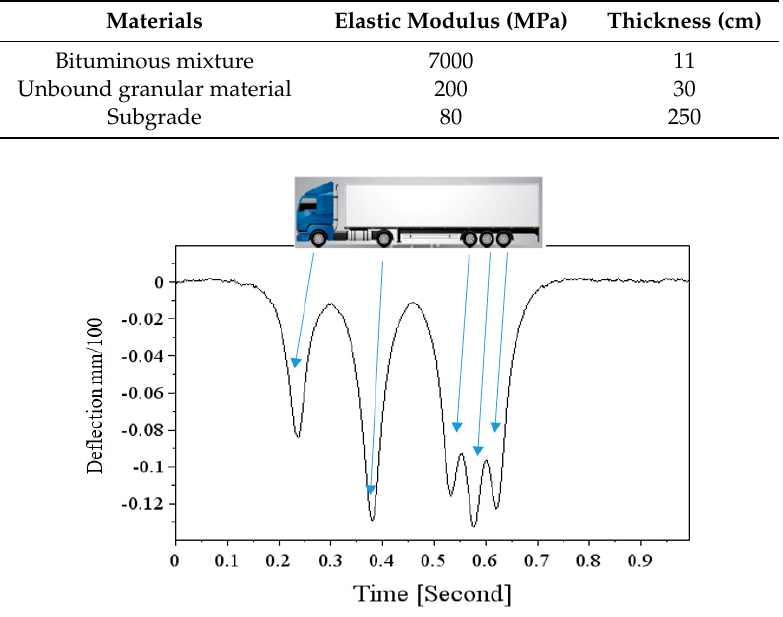
Figure 2. Deflection signal obtained with the ALIZE pavement-modelling software, corresponding to a 5-axle truck load. Table 1. Pavement model.